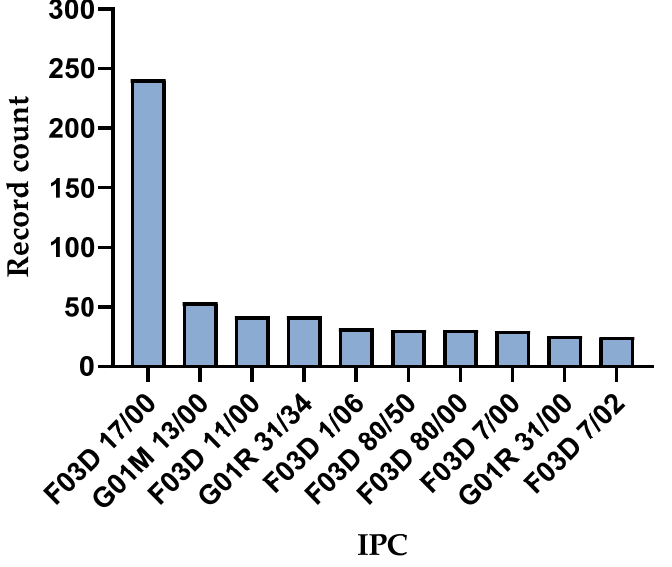
Figure 5. Most-used classification codes in area of development of technologies applied to wind turbines. Table 4. IPC codes in technological prospecting .